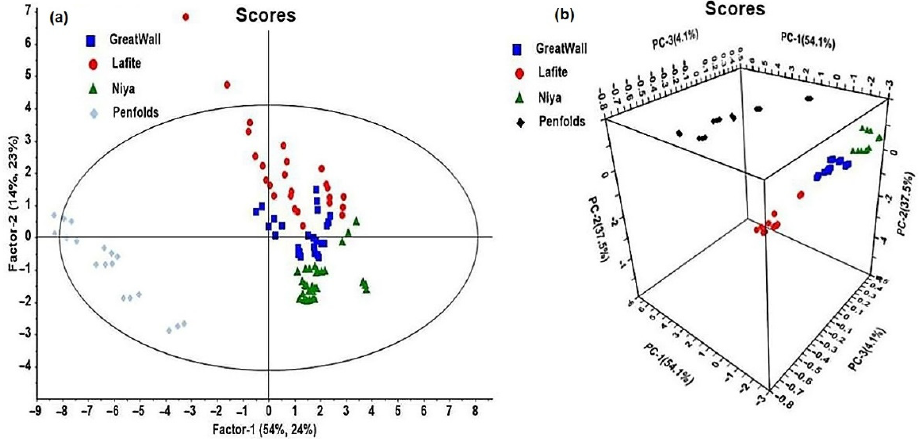
Figure 7. PLS ( a ) and PCA ( b ) scores plot of four wine samples. Table 2. Classification accuracy of BPNN and RF.